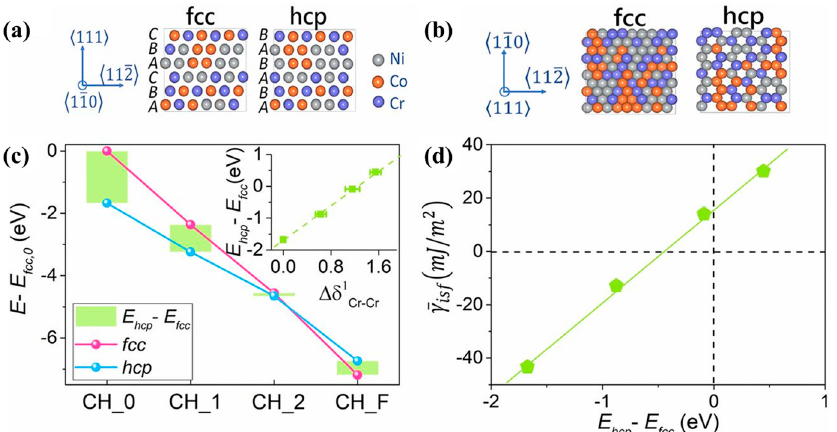
Figure 3. Energies of fcc and hcp structures in NiCoCr solid − solution alloys. ( a , b ) Side and top view of atomic configurations. ( c ) Relative energy difference for fcc and hcp phases at various degrees of LCO. ( d ) Correlation between average SFE γ isf and energy difference for fcc and hcp phases ( E hcp − E fcc ) (Reprinted with permission from Ref. [31]. Copyright 2018,